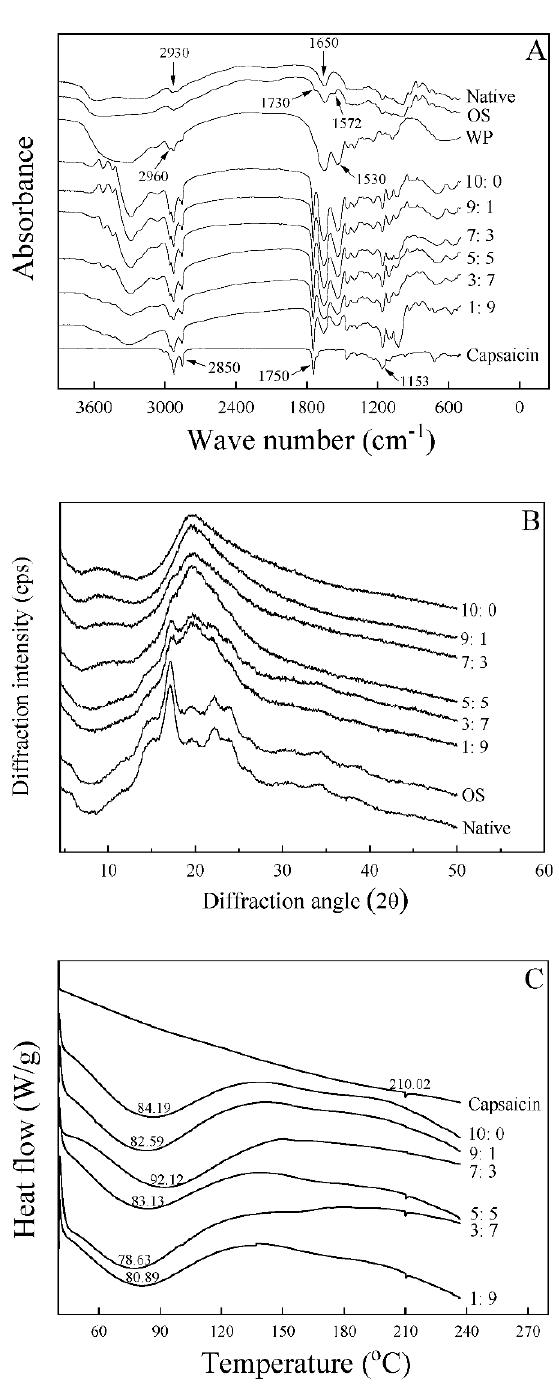
Figure 4. FTIR spectra ( A ), X-ray diffraction pattern ( B ), and DSC thermograms ( C ) of WP-OS-cap- saicin microcapsules. Native, native starch; 10:0, 9:1, 7:3, 5:5, 3:7, and 1:9 represent WP (whey pro- tein):OS (OSA-modified starch).